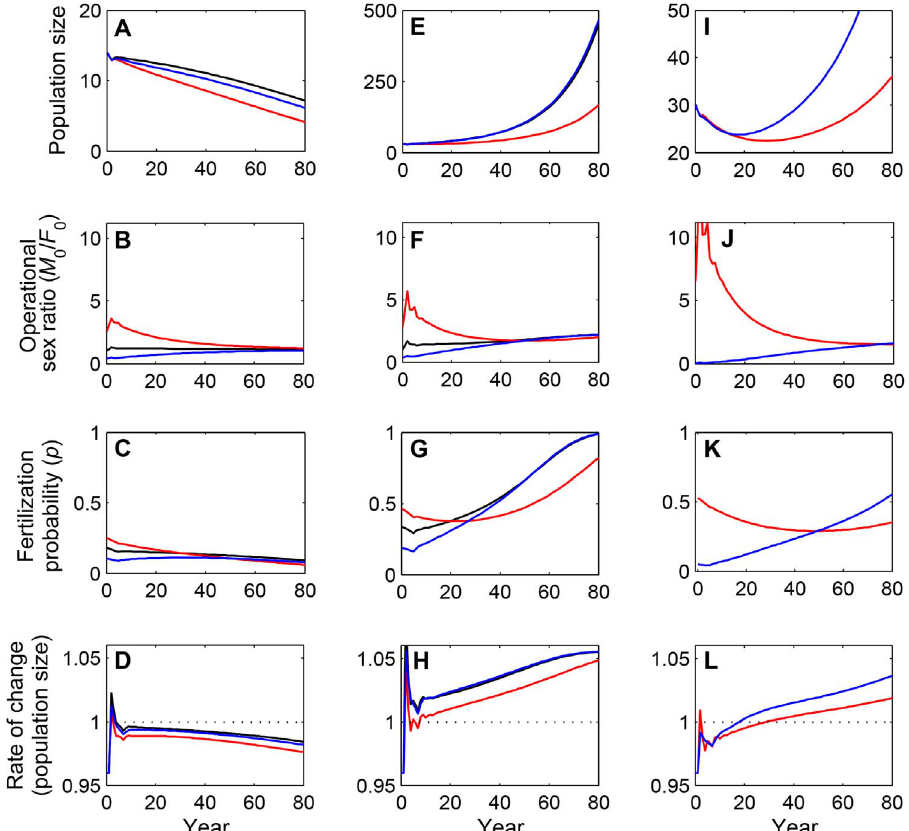
Figure 4. Transient population growth, operational sex ratios and fertilization probabilities for populations near the Allee threshold. Each simulation is initialized with an ‘‘old’’ population, where all females ( F 0 ) and males ( M 0 ) are sexually mature adults at the beginning of the projection, and no female is accompanied by dependent offspring. Populations with male-biased, balanced, and female-biased sex ratios are shown in red, black, and blue, respectively. Population sizes in panels (A,E,I) correspond to independent adults and subadults only, that is, they do not include dependent offspring. (A–D) Three populations where mate limitation leads to extirpation (red: M 0 =10, F 0 =4; black: M 0 =7, F 0 =7; blue: M 0 =4, F 0 =10); (E–H) Three populations that increase to persistence even though initial population growth is slowed by mate limitation (red: M 0 =22, F 0 =8; black: M 0 =15, F 0 =15; blue: M 0 =8, F 0 =22); (I–L) Two populations that initially show a long decline before eventually increasing to persistence (red: M 0 =26, F 0 =4; blue: M 0 =2, F 0 =28). For all populations, the habitat area is set as H =100,000 km 2 .